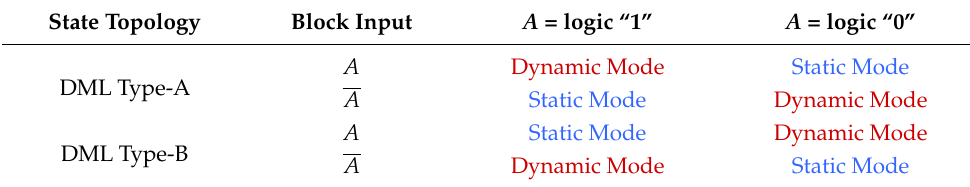
Table 1. Modes of operation for blocks as a function of block topology and input